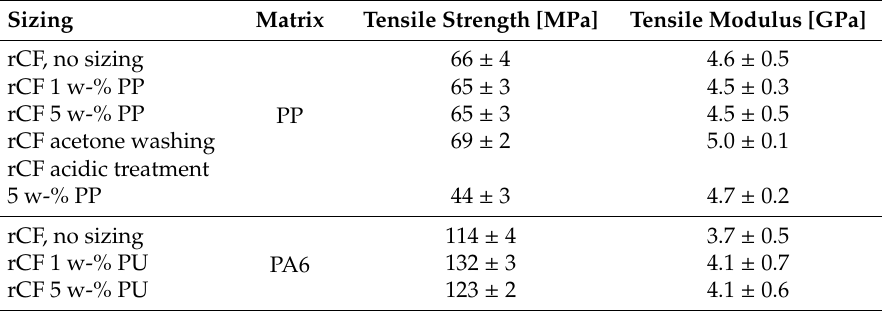
Table 4. Tensile test results for the rCF-PP and rCF-PA6